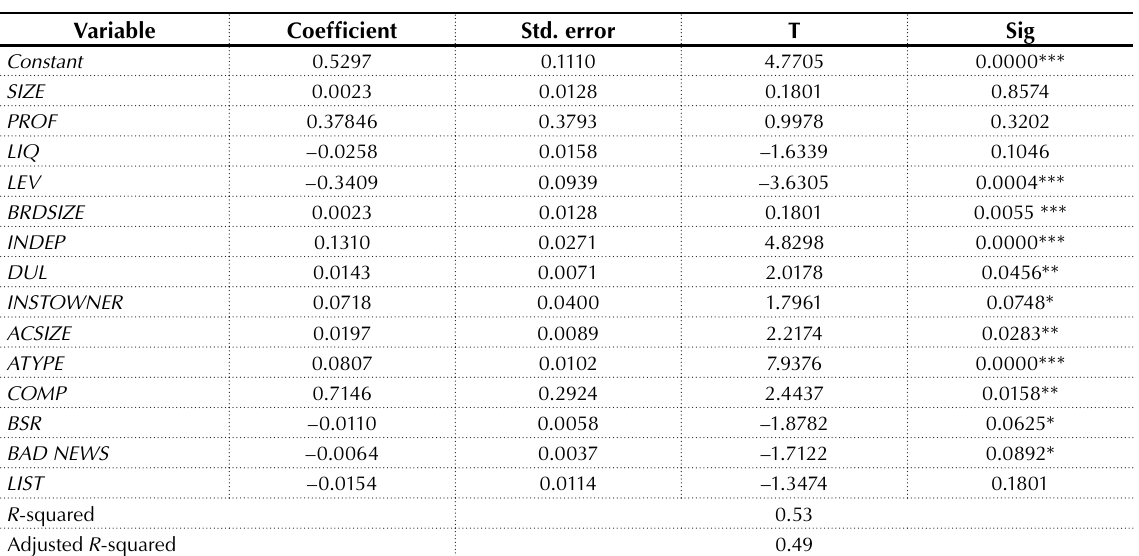
Table 7. Multiple